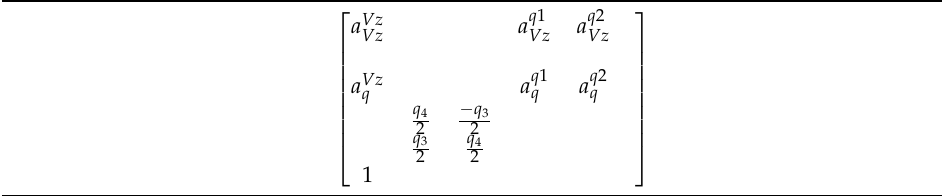
Table 7. Stability matrix for lateral motion A .